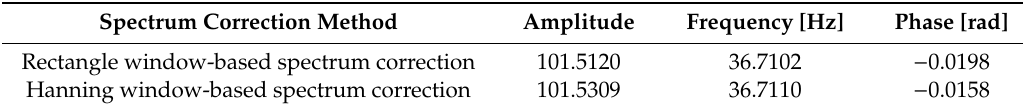
Table 2. Harmonic information derived from spectrum correction methods.